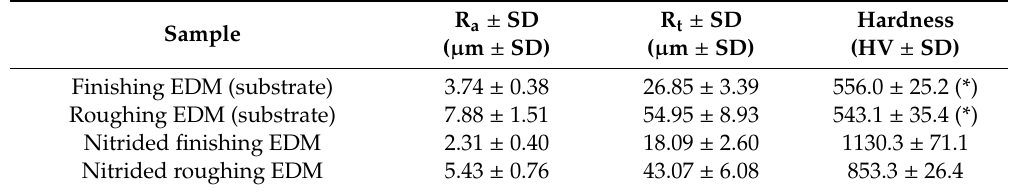
Table 2. Surface roughness and material hardness for the different EDM conditions with and without nitriding.